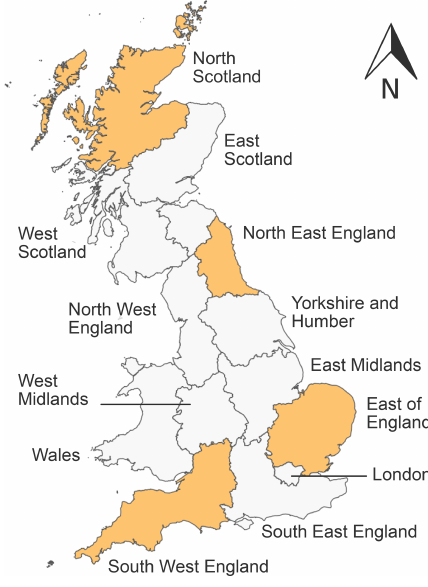
Figure 1. Map of administrative UKCP18 regions used for regional drought characterisation. Regions for which results are shown in the main text are highlighted in